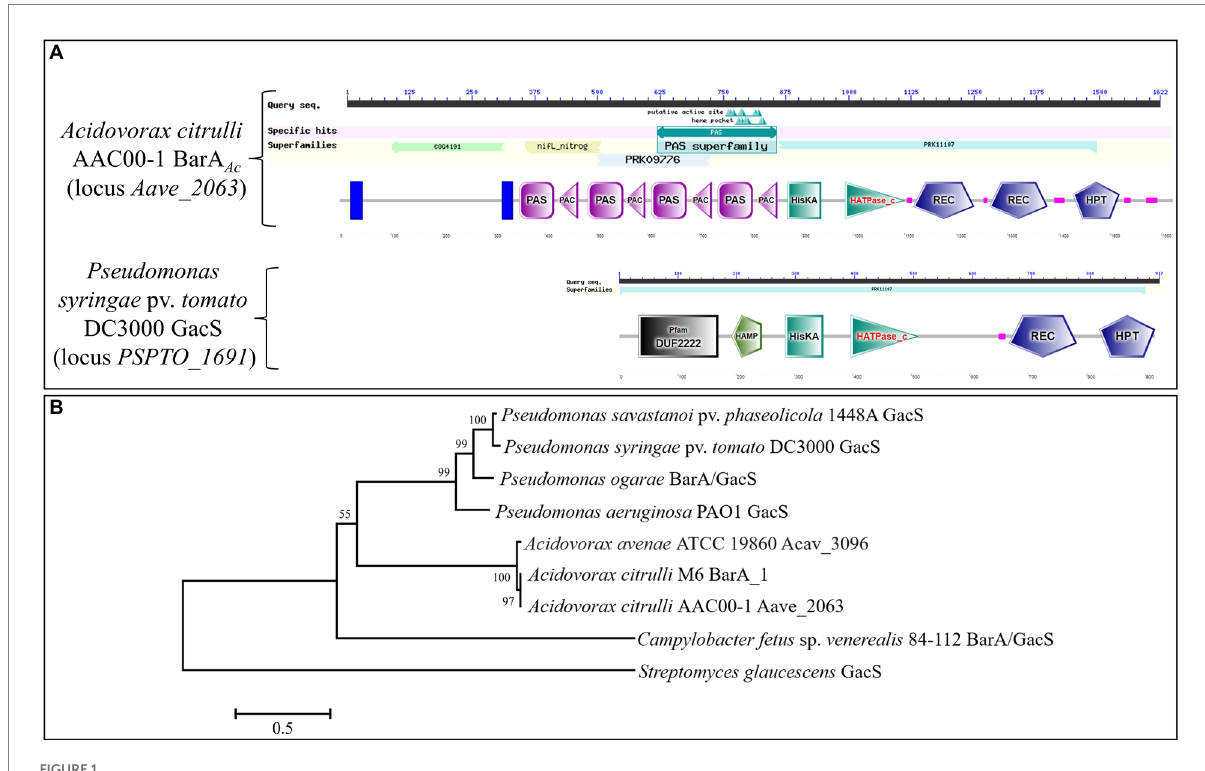
FIGURE 1 Domains of BarA and the phylogenetic tree of BarA proteins. (A) The domain comparison of BarA Ac in Acidovorax citrulli AAC00-1 and GacS in Pseudomonas syringae pv. tomato DC3000. (B) The tree was constructed based on amino acid sequences of BarA proteins using the neighbor- joining method in MEGA 7. Streptomyces glaucescens was used as an outgroup. The bootstrap values (1,000 replicates) were shown at the nodes. The bar indicates sequence